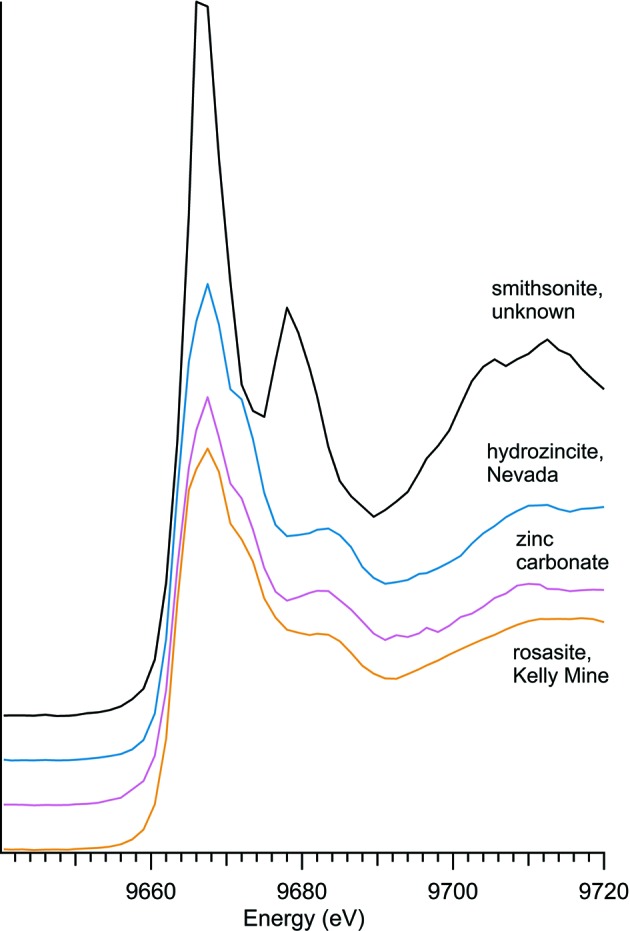
Zinc carbonate spectra.